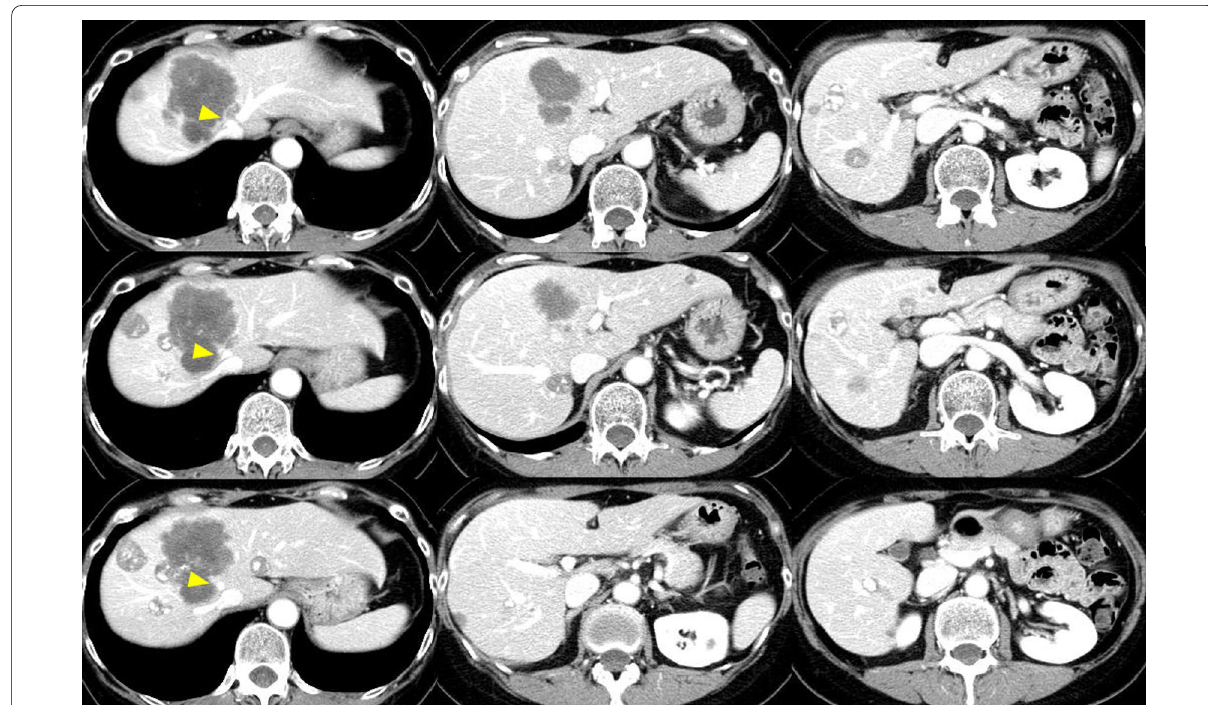
Fig. 2 Computed tomographic findings after chemotherapy. While liver metastases are reduced overall, tumor involving segments 4 to 8 has invaded the MHV near the confluence of the MHV and the LHV (arrowhead)